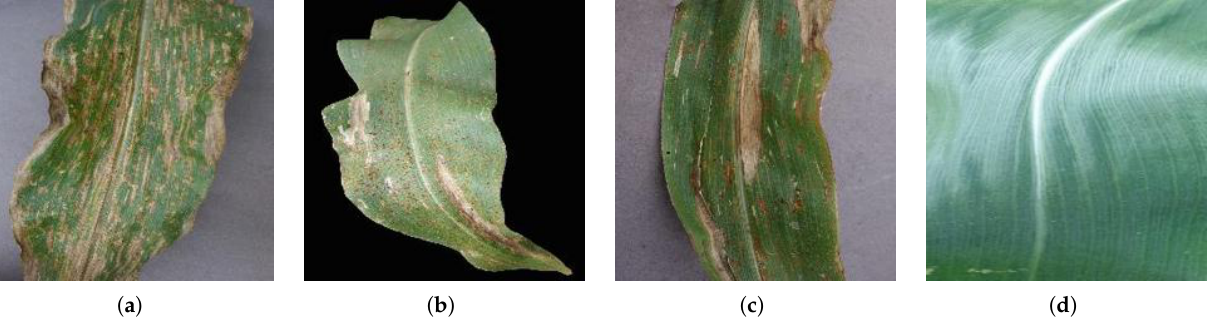
Figure 2. Sample images from the three disease classes and the healthy one: ( a ) Cercospora leaf spot. ( b ) Common rust. ( c ) Northern leaf blight. ( d )